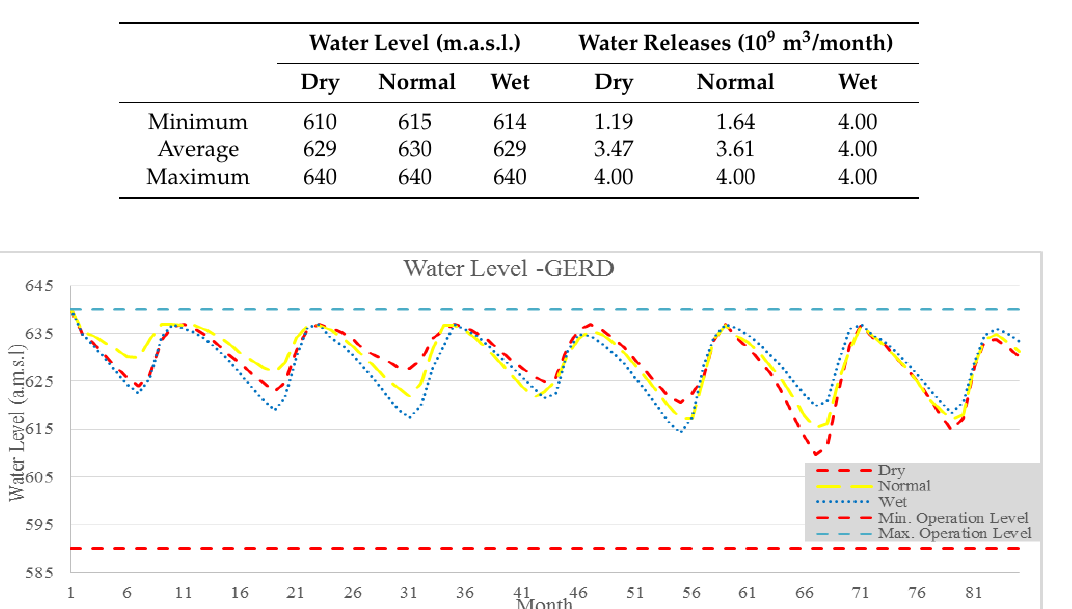
Table 4. Monthly water levels and releases of the GERD.